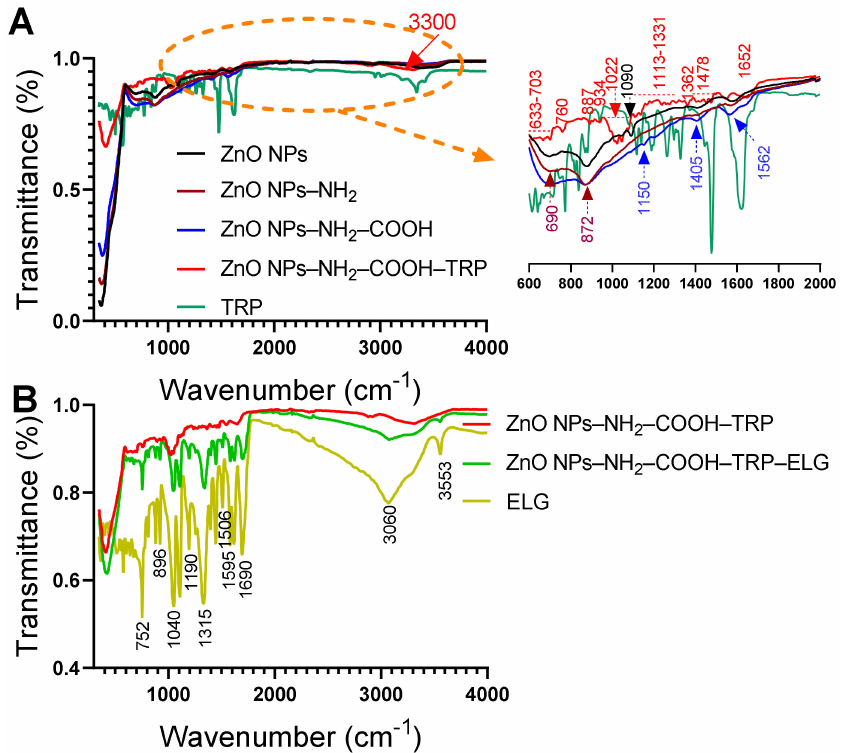
Figure 6. FT–IR analysis of materials. ( A ) FT–IR spectra show the materials before and after surface functionalization with amino groups, carboxylic acid, and TRP. ( B ) FT–IR spectra show the materials before and after ELG loading. The powder was analyzed for each material, with an ATR unit of the FT–IR